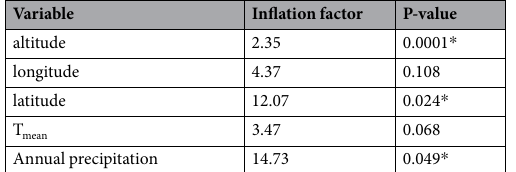
indicate a significant differential distribution pattern of Carassius species complex that the hexaploids have wider geographic distribution than the tetraploids. Association between geographic/climatic variables and the differential distribution pattern in Carassius species complex. A total of 5 geographic/climatic variables including altitude, longitude, lati- tude, average annual temperature (T mean ) and annual precipitation were used to exam the association between geographic/climatic variables and the differential distribution pattern (Table S2). Via redundancy analysis, dif- ferential distribution pattern in Carassius species complex was revealed to be significantly associated with alti- tude (inflation factor = 2.35, p = 0.0001), latitude (inflation factor = 12.07, p = 0.024) and annual precipitation (inflation factor = 14.73, p = 0.049), whereas it was unrelated to the other variables including T mean and longitude (Table 1). And, the hexaploid frequency was positively correlated to altitude and latitude and negatively related to annual precipitation, while the tetraploid frequency was negatively related to altitude and latitude and positively correlated to annual precipitation (Fig. 2a). Moreover, the examined 34 populations were respectively assigned to four different hexaploid frequency groups (0–50%, 50–85%, 85–99%, 100%) to clarify relative association between the three significant geographic/climatic variables and the distribution pattern (Table S2). Significantly, only 10.2% of tetraploids but 89.8% of hexaploids exist in the populations at altitude higher than 456.9 m, and all-hexaploid populations generally distribute at the over 723.0 m elevation (Fig. 2b). Moreover, 89.3% of hexa- ploids spread in the populations with latitude over 35.6°N, while only 10.7% of tetraploids exist in this latitude